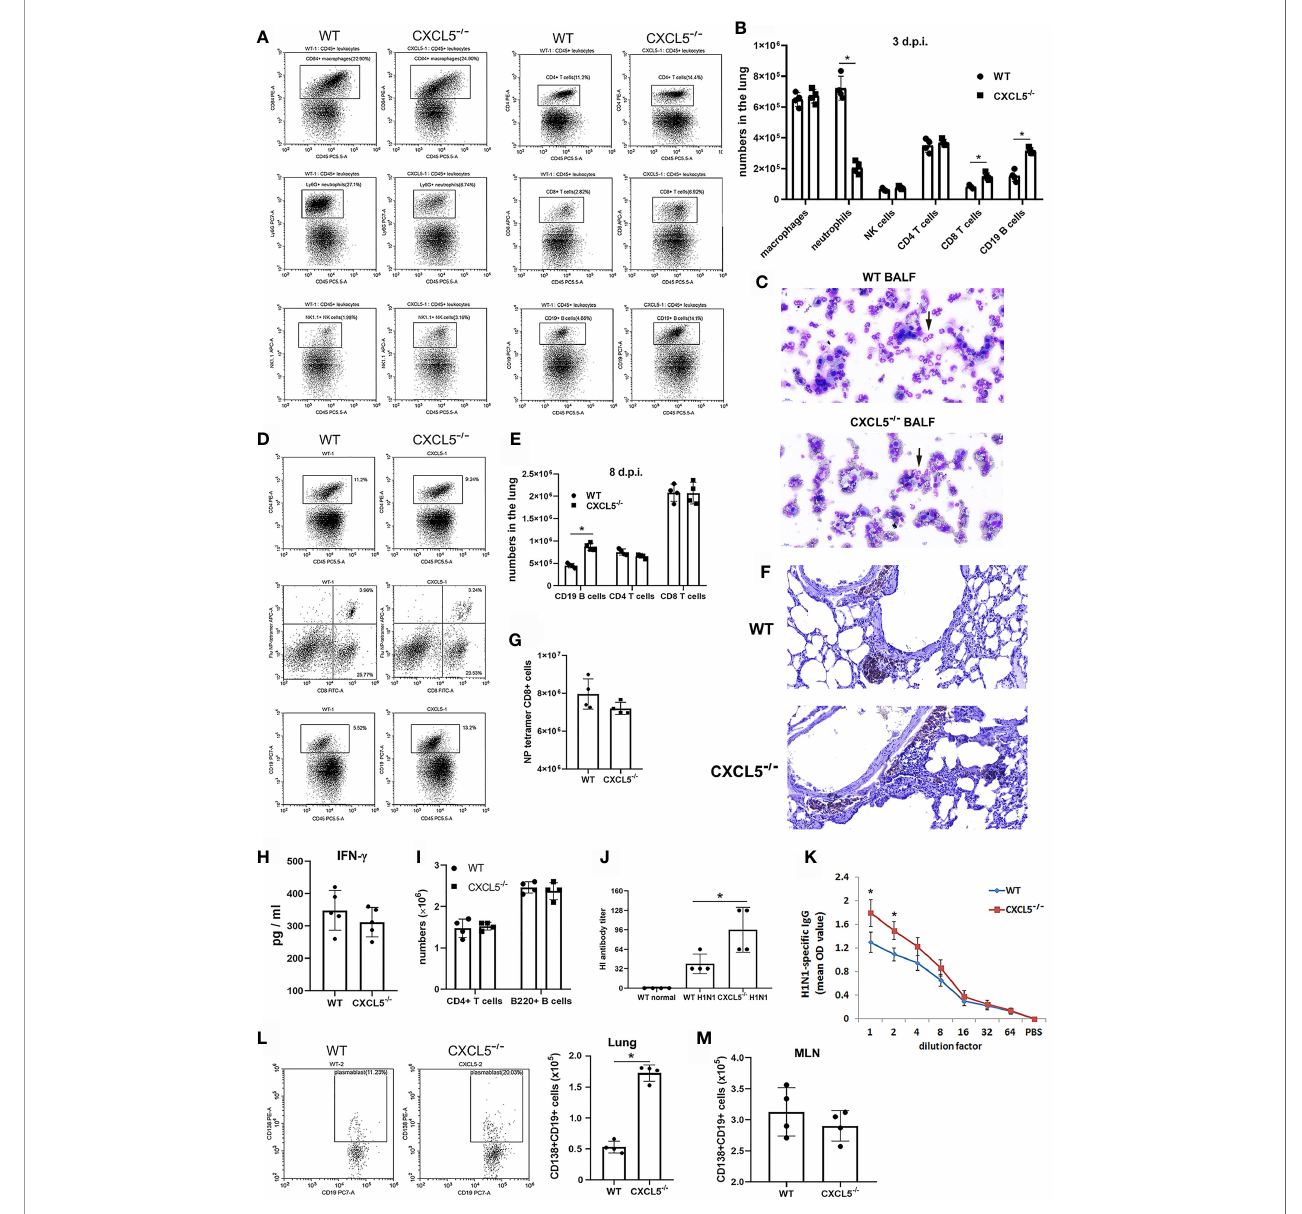
FIGURE 5 | Pulmonary innate and adaptive immune responses induced by in fl uenza infection in WT and CXCL5 -/- mice. (A) Single lung cells were collected from WT and CXCL5 -/- mice at 3 d.p.i. and analyzed by fl ow cytometry to detect macrophages (CD64+CD45+), neutrophils (Ly6G+CD45+), NK cells (NK1.1+CD45+), CD4 T cells (CD4+CD45+), CD8 T cells (CD8+CD45+), and CD19 B cells (CD19+CD45+). (B) Numbers of different leukocyte subsets among pulmonary CD45+ leukocytes at 3 d.p.i. (n=4). (C) Microscopic view of BALF leukocytes from WT and CXCL5 -/- mice collected at 3 d.p.i. and cytospun. Black arrows, neutrophils (×400 magni fi cation). (D) Single lung cells were collected from WT and CXCL5 -/- mice at 8 d.p.i. and analyzed by fl ow cytometry to detect CD4 T cells (CD4+CD45+), CD8 T cells (CD8+CD45+), CD19 B cells (CD19+CD45+), and in fl uenza-speci fi c CD8 T cells (APC-conjugated class I tetramers loaded with the in fl uenza virus NP peptide ASNENMETM). (E) Numbers of different leukocyte subsets among pulmonary CD45+ leukocytes at 8 d.p.i. (n=4). (F) Lung sections from WT and CXCL5 -/- mice were stained at 3 d.p.i. with an anti-CD19 antibody and hematoxylin (×200 magni fi cation). (G) Numbers of NP tetramer-positive CD8+ T cells among pulmonary CD45+ leukocytes at 8 d.p.i. (n=4). (H) The levels of IFN- g in BALF from WT and CXCL5 -/- mice at 8 d.p.i. were determined by ELISA (n=5). (I) The total numbers of CD4+ T cells and B220+ B cells in the MLNs at 8 d.p.i. were determined by cell counting together with fl ow cytometry (n=4). (J) The HI titers of the BALF samples from WT and CXCL5 -/- mice at 8 d.p.i. against H1N1 virus were evaluated (n=4). (K) Measurements of in fl uenza-speci fi c total IgG in the BALF of WT and CXCL5 -/- mice infected with the H1N1 virus at 8 d.p.i. (n = 5). (L) The numbers of plasmablasts among pulmonary B cells were detected using anti-CD19 and anti-CD138 antibodies by fl ow cytometry of samples from WT and CXCL5 -/- mice at 8 d.p.i. (n=4). (M) The total numbers of CD138+CD19+ B cells in the MLNs at 8 d.p.i. were determined by cell counting together with fl ow cytometry (n=4). The error bars represent the SDs. *P < 0.05 based on Student ’ s t